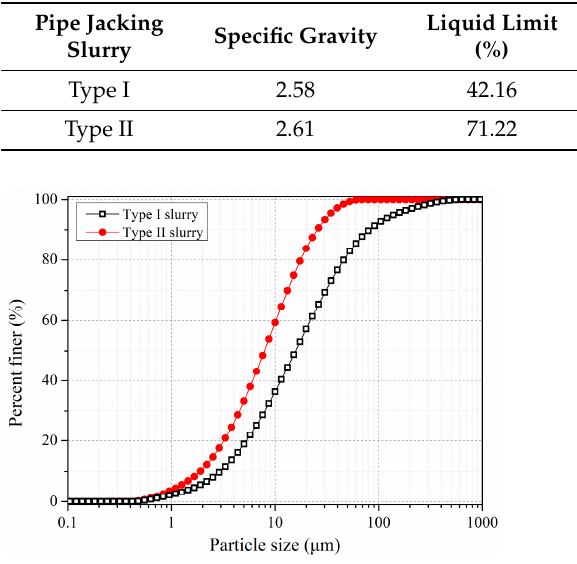
Table 1. Basic properties of the pipe jacking slurry.